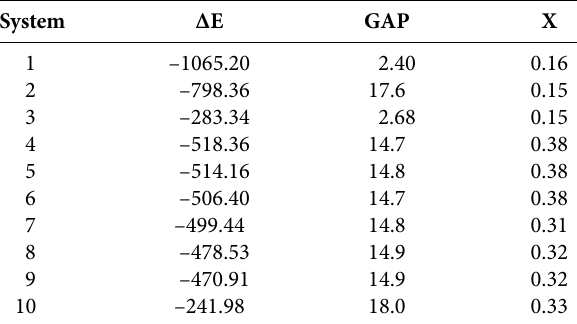
Table 1. MP2/LANL2DZ dissociation energies with zero point cor- rections, HOMO/LUMO gaps and absolute electronegativity (Χ) are